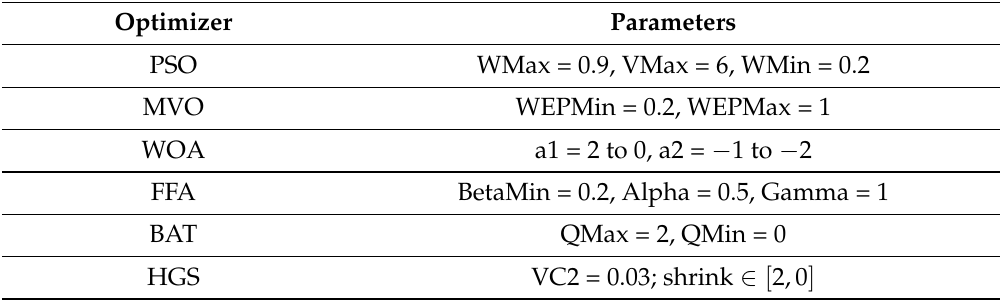
Table 3. Parameters settings of FS